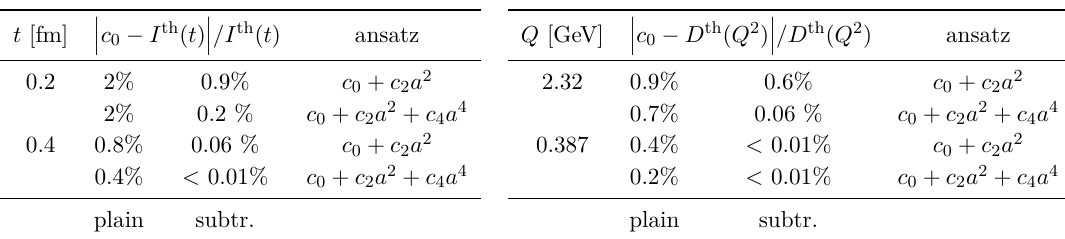
Table 2 . Accuracy of the continuum limit of I th ( t ) (left) and D th ( Q 2 ) (right) expressed in terms of the relative difference between the continuum estimate c 0 and the known continuum value. Three thermal lattices are used for the extrapolation, with N t = 16 , 20 , 24 and whose temperature is set to T = 246 . 25 MeV. The label ‘plain’ refers to a continuum estimate obtained by fitting the plain lattice observables I th ( t ) and D th ( Q 2 ) , while in the case ‘subtr.’ the logarithmic cutoff effects are subtracted prior to performing the fit as follows, I th ( t ) − ˜ c I a 2 log(1 / ( Ta )) , D th ( Q 2 ) − ˜ c D a 2 log(1 / ( Ta )) . The analytic values of the coefficients ˜ c I and ˜ c D are given in eqs. (3.9) and (3.11) respectively.